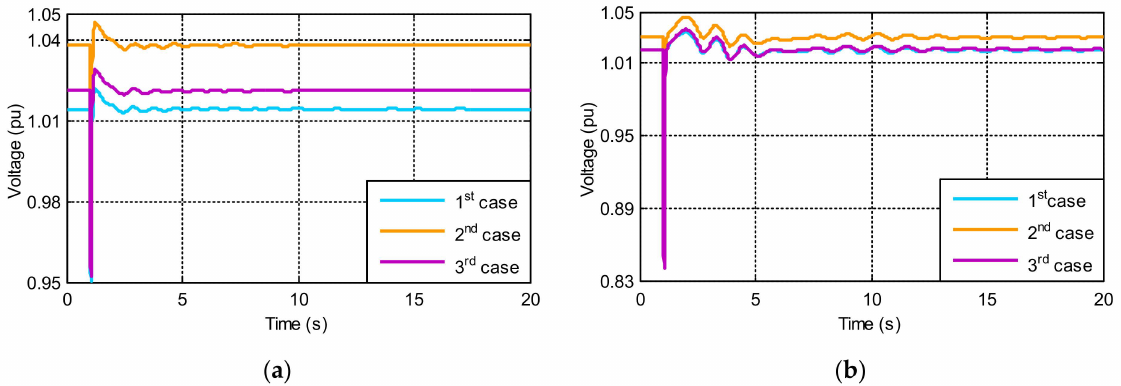
Figure 10. Voltage transient response of the power system versus bus disturbance at different points: